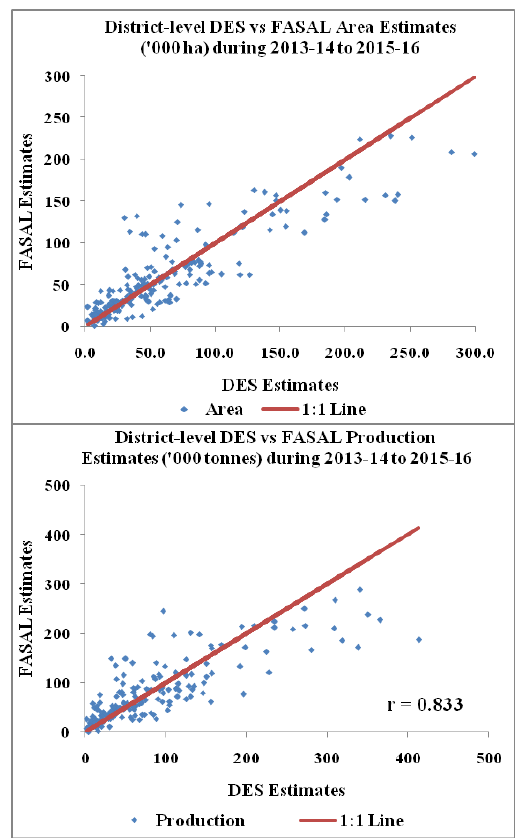
Figure 14: District-level comparison of DES and FASAL Rapeseed & Mustard